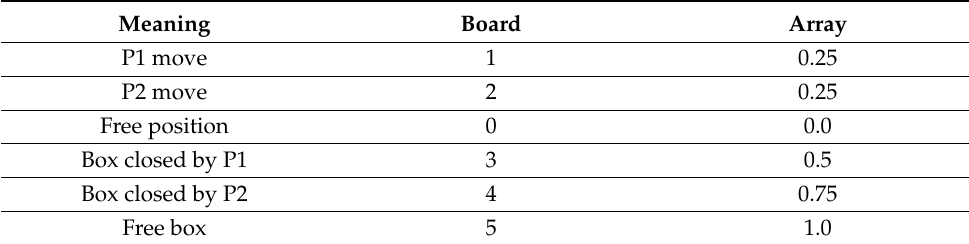
Table 2. Mapped values from board to neural network.